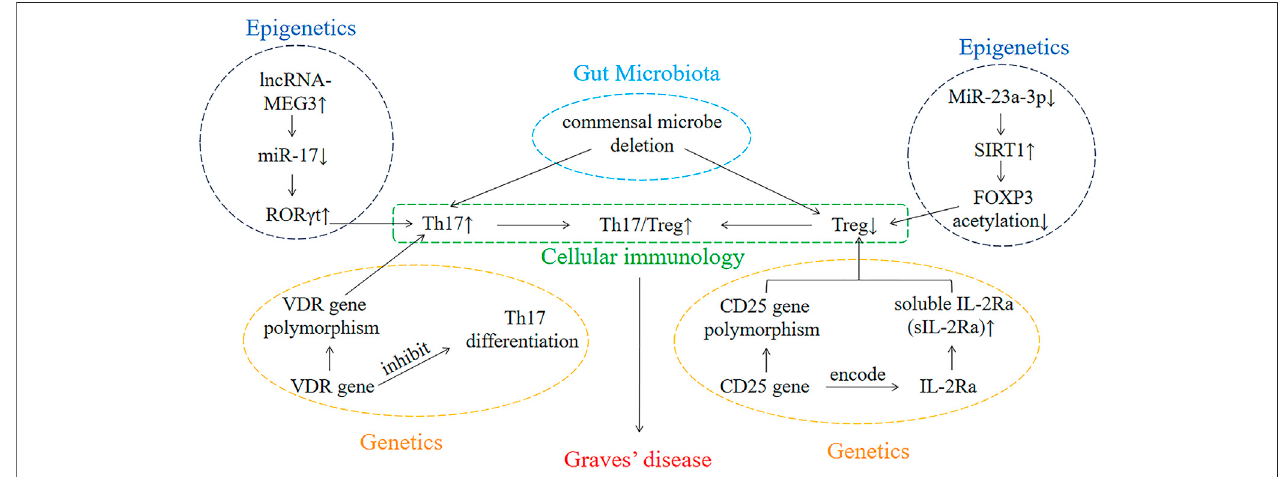
FIGURE 1 | The interaction of genetics, epigenetics, cellular immunology, and gut microbiota involved in the development of GD.